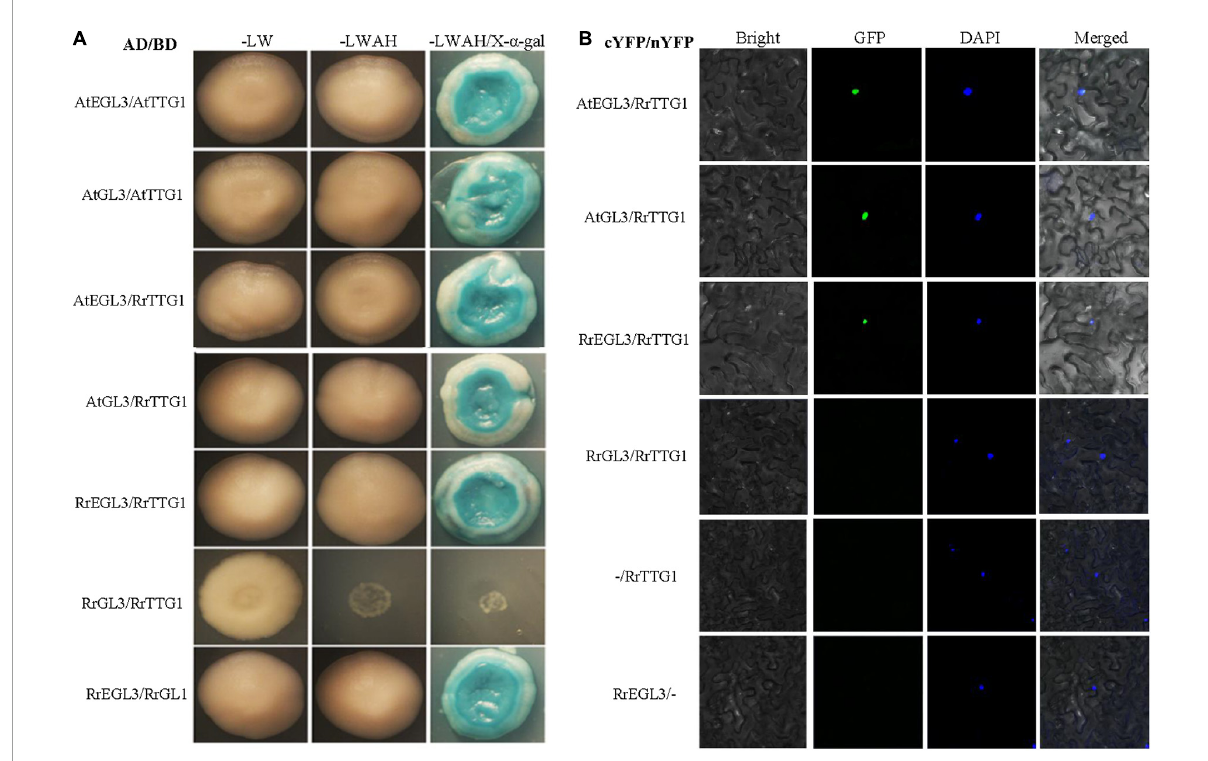
FIGURE6 RrTTG1 only interacted with RrEGL3 to form the RrTTG1-RrEGL3-RrGL1 complex. (A) Y2H assay testing the interaction between RrTTG1 and GL3/EGL3/RrGL3/RrEGL3. Each combination of AD and BD plasmids was co-transformed into yeast strain AH109 separately, and all transformants were grown on SD-Trp-Leu (SD-LW), SD-Trp-Leu-Ade-His (SD-LWAH), and SD-LWAH-X- α -gal medium. The images were photographed at 5 day after incubation. All the controls were displayed in Supplementary Figure 1 . (B) BiFC assay testing the interactions between RrTTG1 and GL3/EGL3/RrGL3/RrEGL3. Each combination of cYFP and nYFP was transiently expressed in Nicotiana benthamiana leave, and the YFP fluorescence signal was visualized and photographed after 48